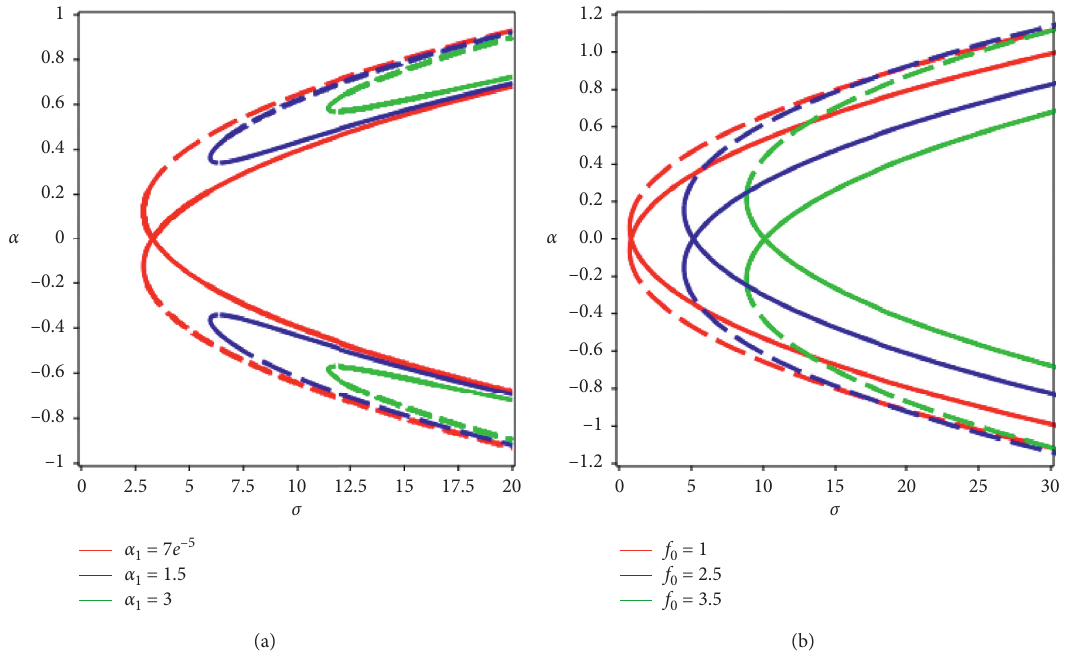
Figure 7: Frequency response for the 1/3-order superharmonic resonance. (a) Ω ≈ 3, α � 23 . 4348. Solid and broken lines are used for the loci of stable and unstable responses, α 2